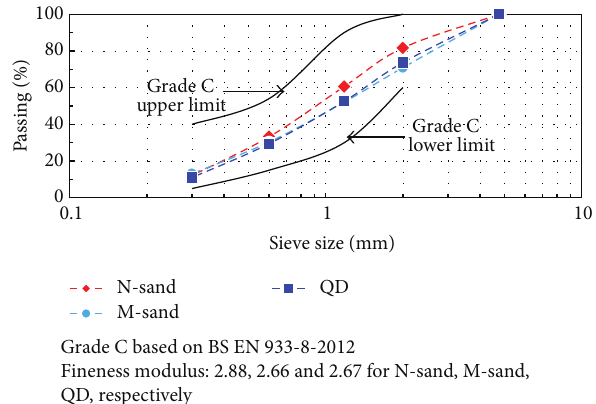
Table 3: Specific gravity and absorption of N-sand, M-sand, and